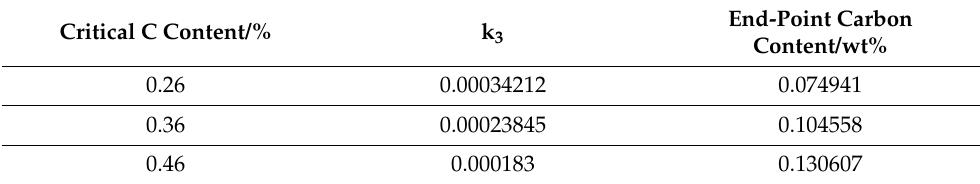
Table 3. The effect of critical carbon content on model